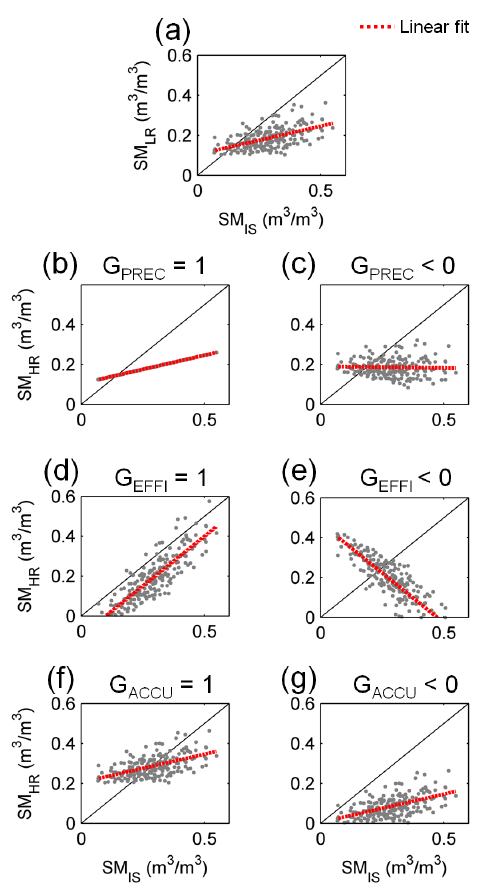
Figure 4. ( a ) LR vs. in situ soil moisture (synthetic data). ( b–g ) High resolution (HR) disaggregated vs. in situ soil moisture for six different disaggregation scenarios (synthetic